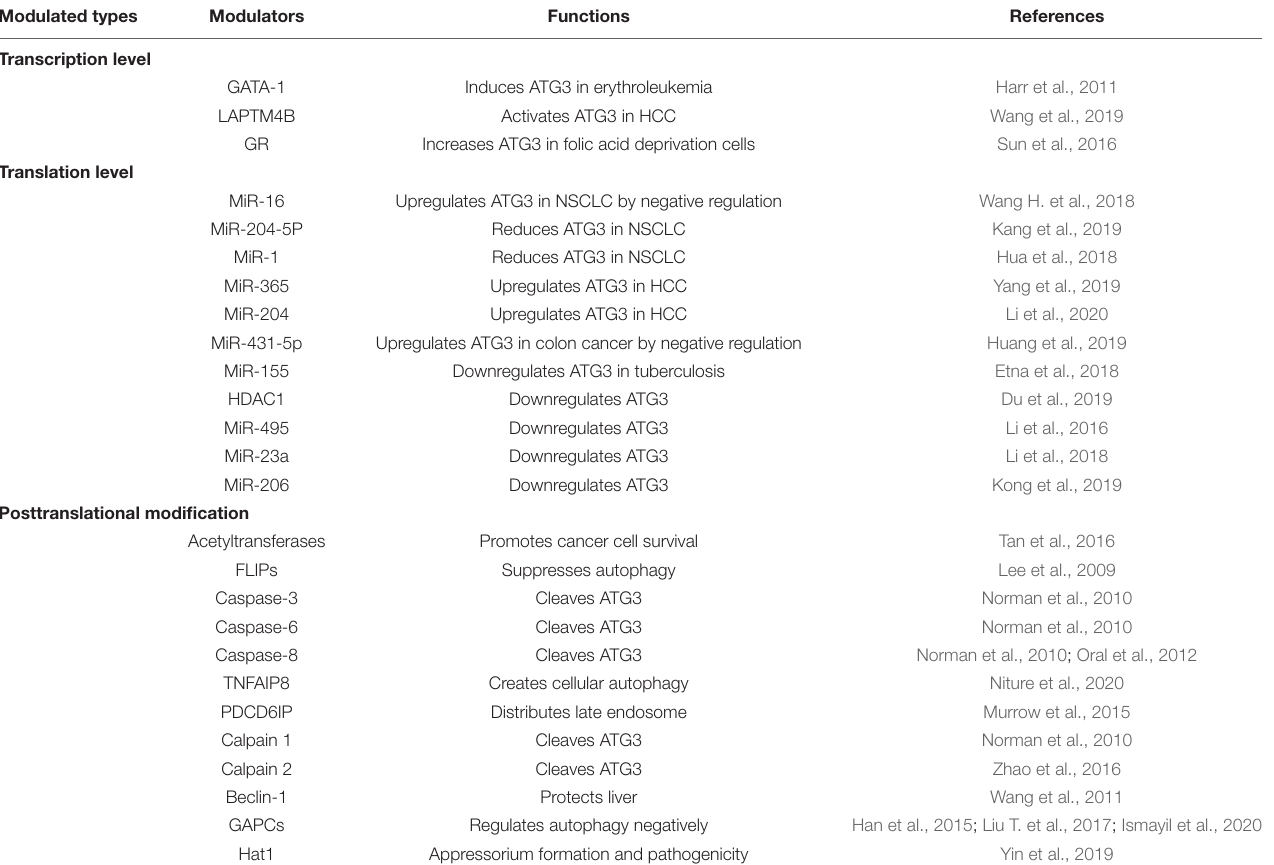
TABLE 1 | ATG3 modulators and functions.